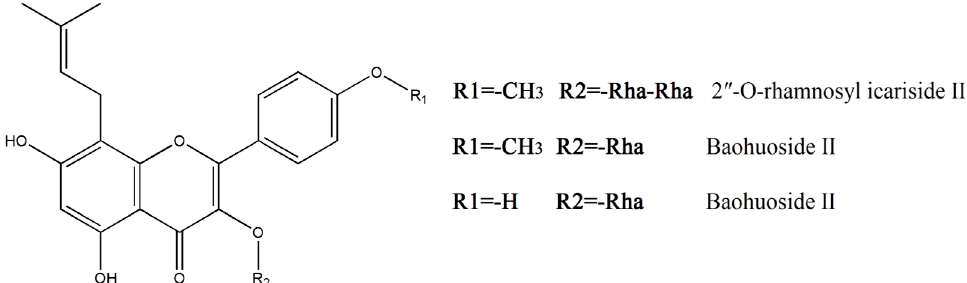
Figure 1. Chemical structures of 2 ″ - O -rhamnosyl icariside II, baohuoside I and baohuoside II. (Rha = rhamnose).